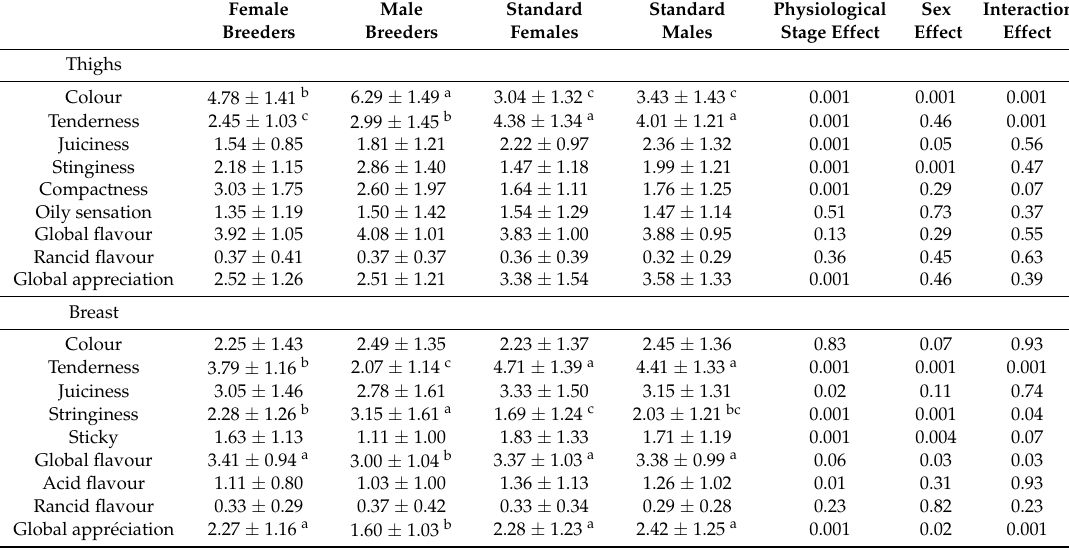
Table 6. Sensorial analysis of cooked thigh and breast meat from males and females of breeder and standard turkeys ( n = 10).